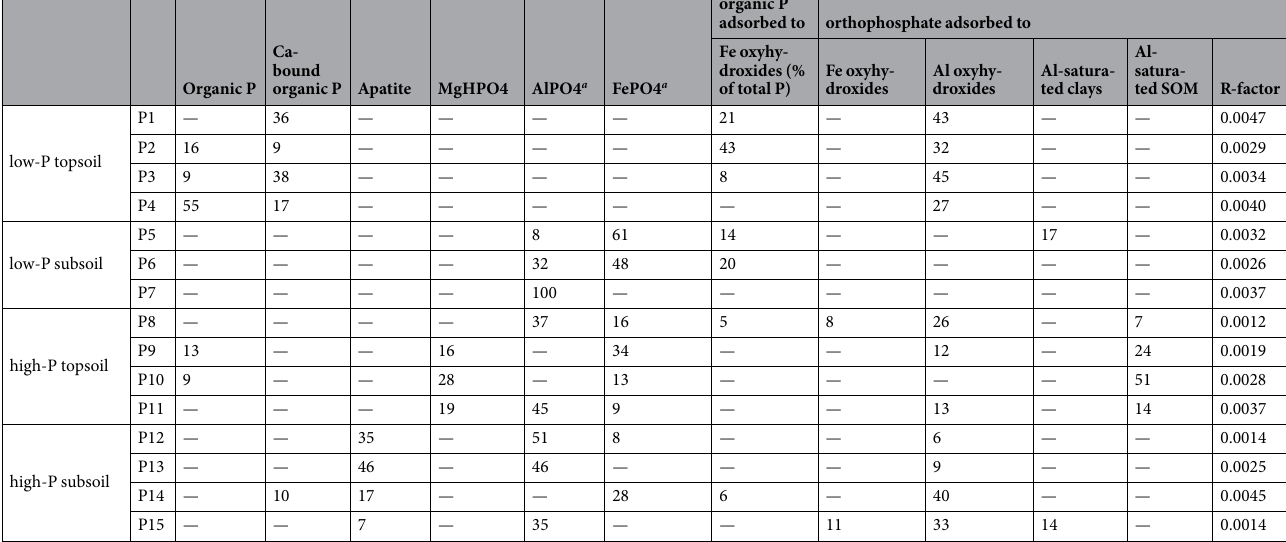
Table 2. Results from linear combination fitting of synchrotron-based X-Ray Absorption Near Edge Structure (XANES) spectra by various phosphorus (P) reference standards (details: see Methods section). a Includes orthophosphate bound to Al and Fe oxyhydroxides by surface precipitation, respectively. Fifteen P micro-sites (P1 to P15) were investigated on soil aggregates. Quality of the fit given by R-factor; accuracy of the fitting 5–10% 36